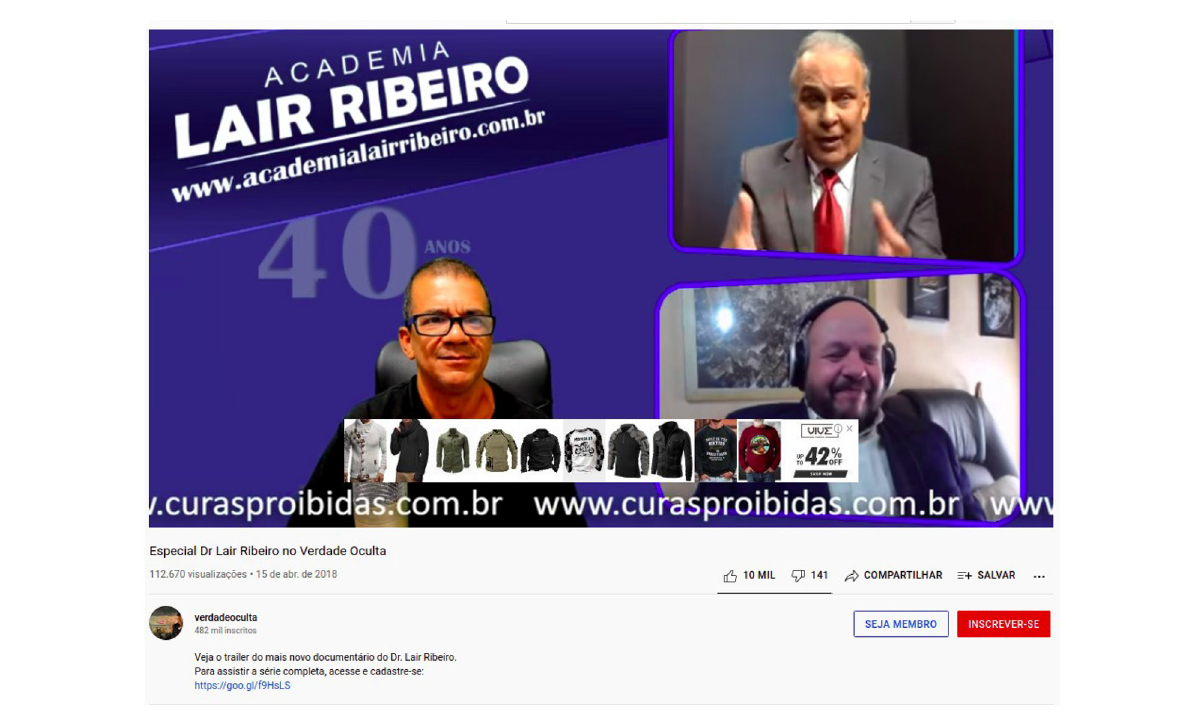
FIGURE6 Dr. Lair Ribeiro Oficial ’s interview on the channel Verdade Oculta . Verdade Oculta was congratulated for the courage of presenting “revolutionary ideas” to the audience, while Dr. Lair Ribeiro Oficial promoted his documentary “Forbidden Cures,” a series of videos that promises to reveal the “truth” about the pharmaceutical